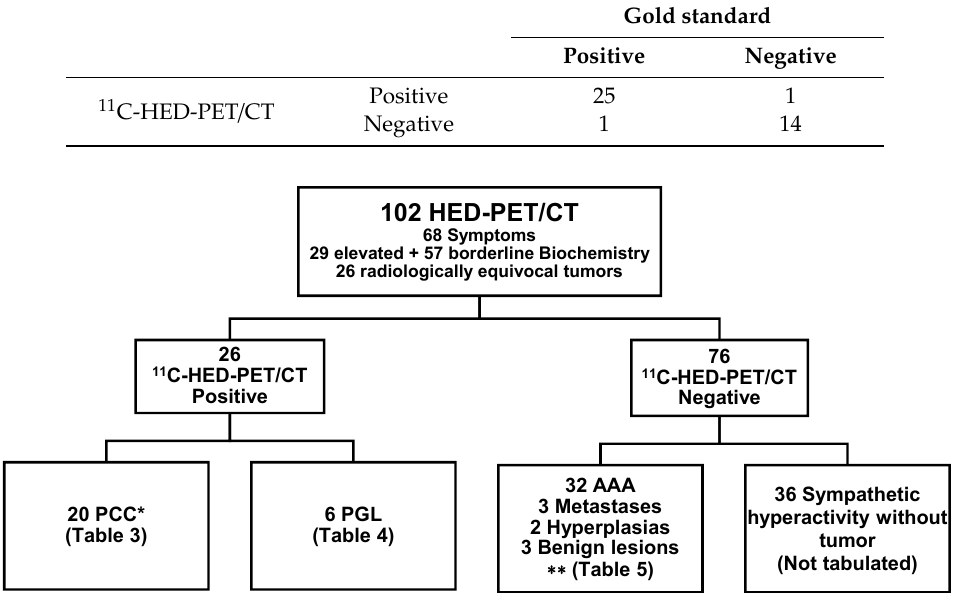
Table 2. 11 C-HED-PET / CT results in the 41 patients operated on, with correlation to findings at surgery and histopathology (gold standard).